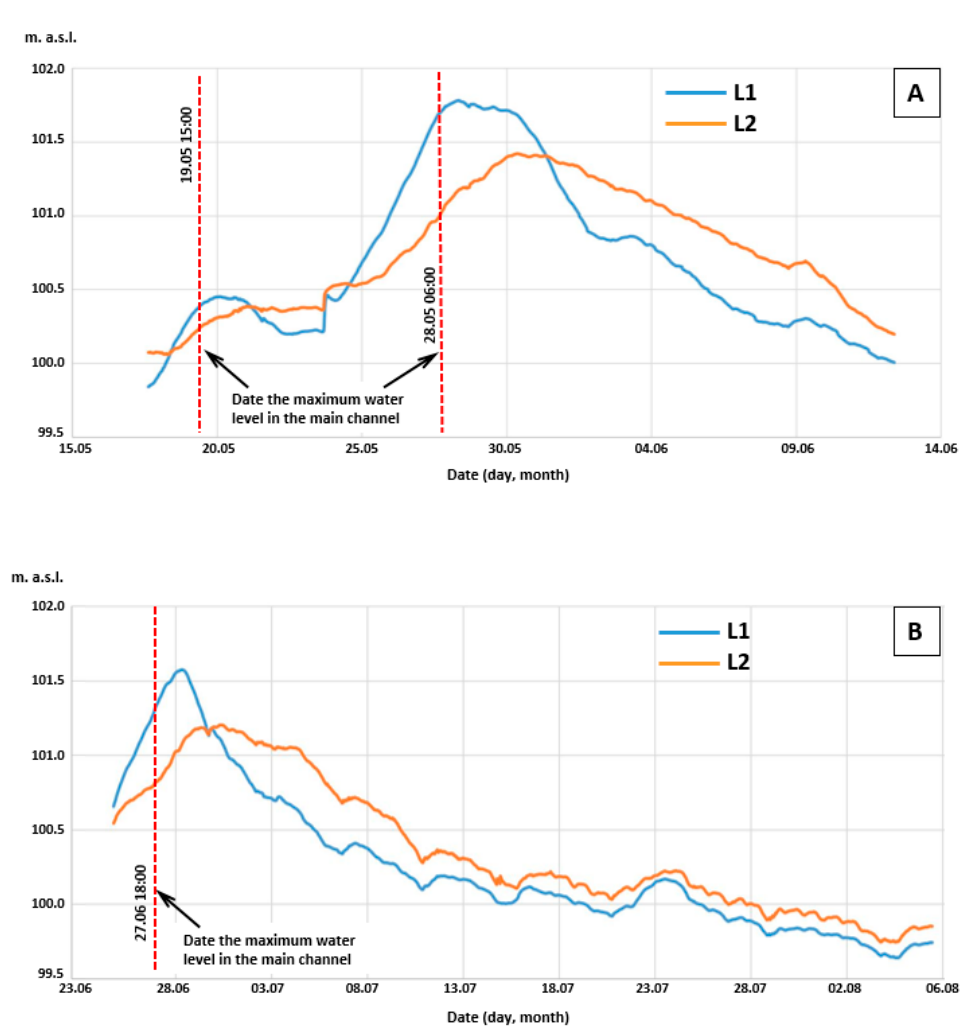
Figure 8. Head equipotential in measuring points during the surge in 2019 ( A ) and 2020 ( B ). The red line marks the maximum water level between the embankments (peak of the surge).